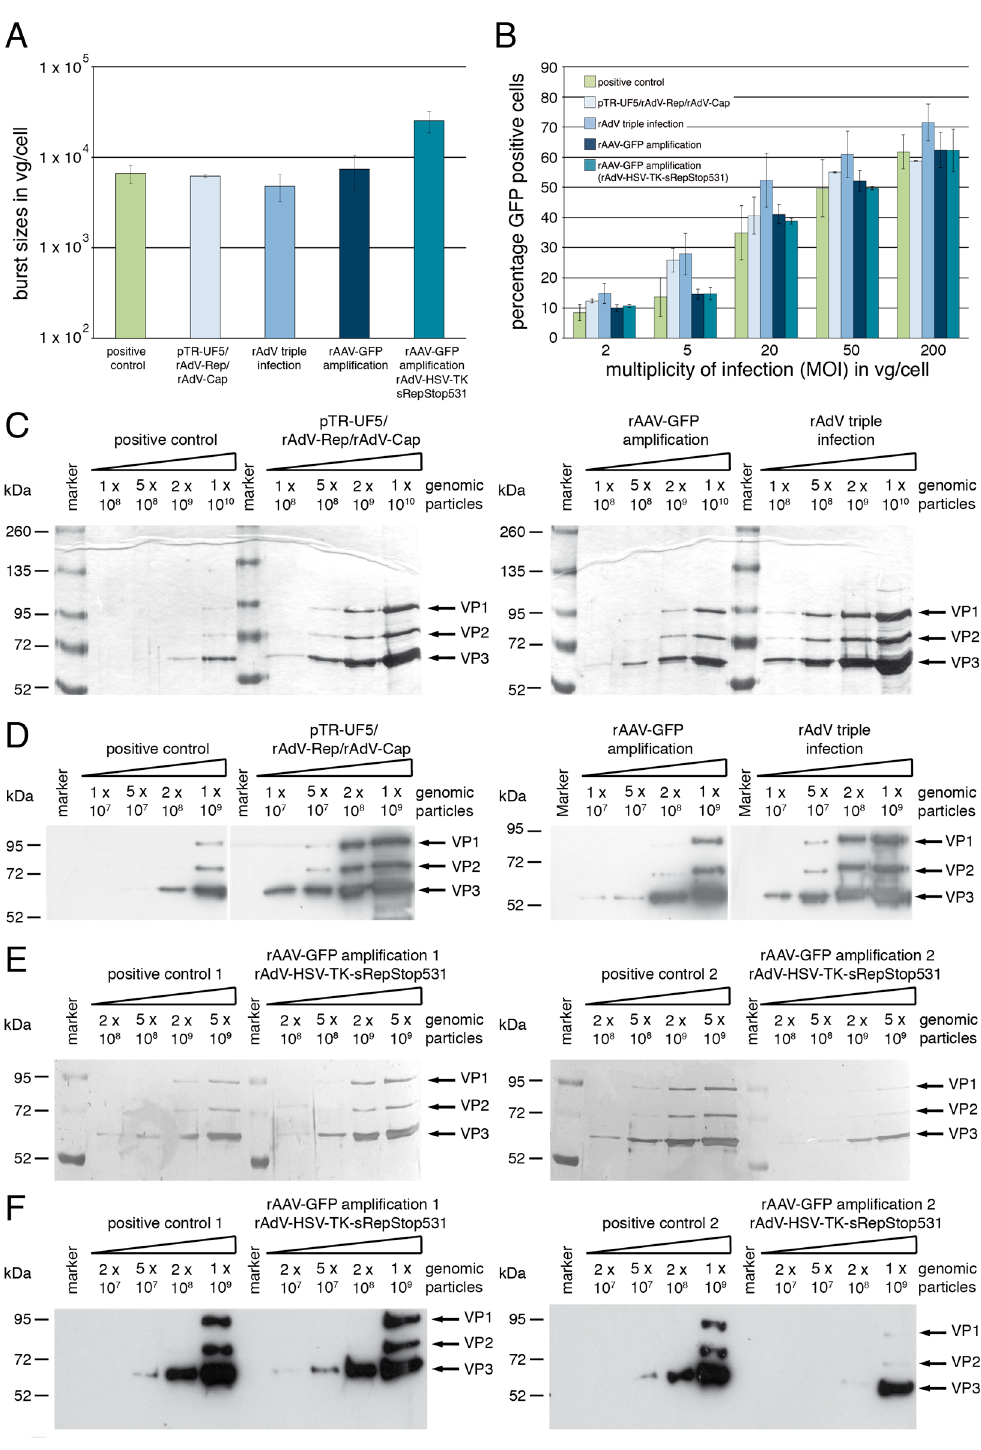
Figure 6. Characterization of affinity-purified rAAV2-GFP vector preparations generated with the help of recombinant adenoviruses. ( A ) Mean burst sizes in genomic particles per cell (vg/cell) for affinity-purified rAAV2-GFP vector preparations generated with different packaging approaches as indicated. The middle three bars involve rAdV-M2-Tet-sRep for expression of Rep proteins, while the right bar shows the preparations from the rAAV-GFP amplification protocol with rAd-HSV-TK-sRep-Stop531. Means were obtained from three preparations for the positive control (pTR-UF5/pDG co-transfection), the rAdV triple infection and the rAAV-GFP amplification mediated by the combination of rAd-HSV-TK-sRep-Stop531 and rAdV-HSV-TK-Cap. For the remaining setups, two preparations were averaged. Standard deviations are indicated by the corresponding error bars. ( B ) Percentage of GFP positive cells after transduction of HeLa cells with 5 different